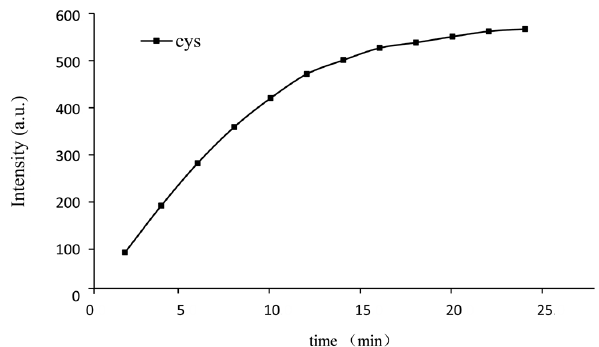
Figure 5. Kinetic analysis of the probe towards Cys (10 μ M probe with 50 equiv. of Cys) in buffer solution (DMSO:PBS = 4:6, pH = 7.4). λ ex = 325 nm, λ em = 450 nm.